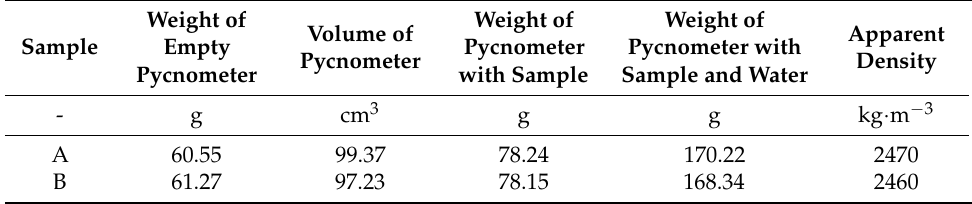
Table 3. Parameters of pycnometry